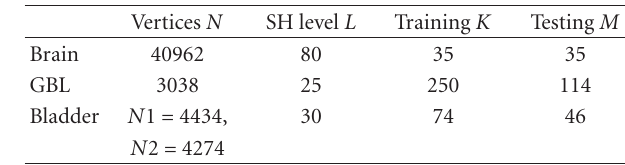
Table 1: FEM Model setup.